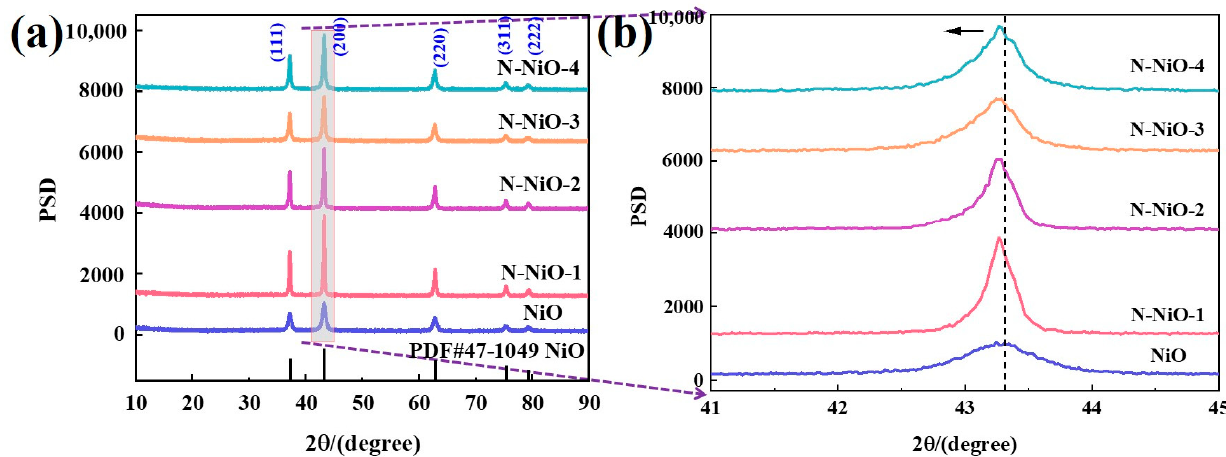
Figure 1. ( a ) The XRD patterns of the prepared samples; ( b ) local amplification diagram.